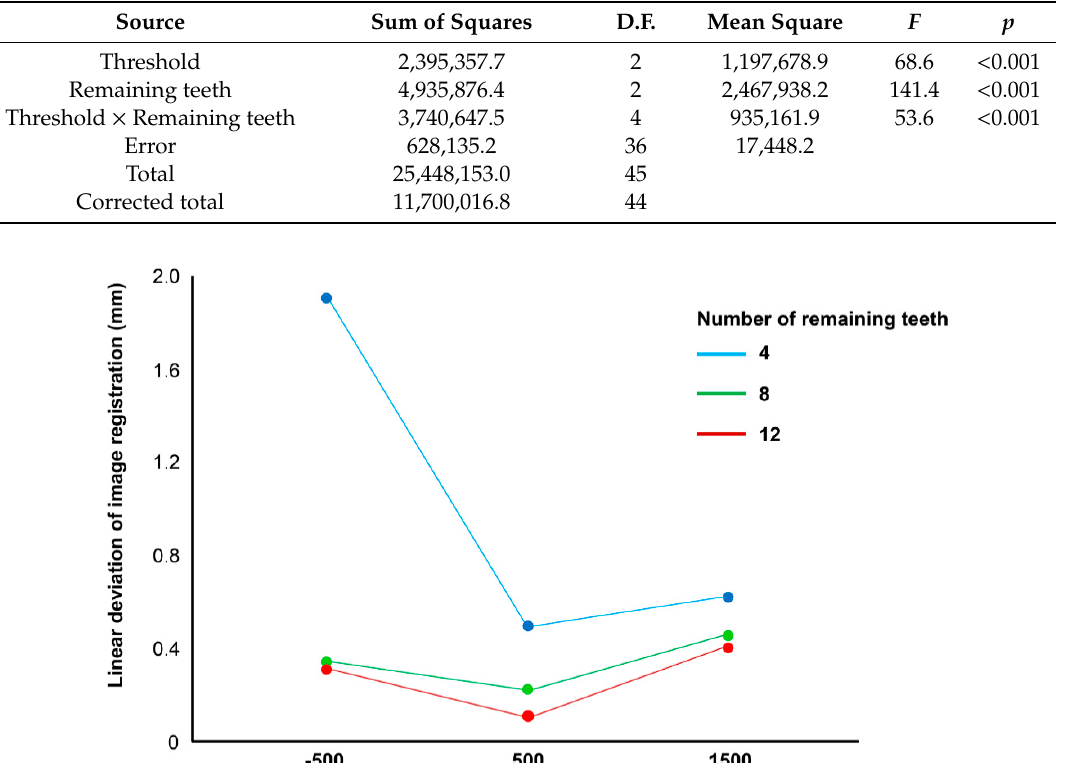
Table 4. Variations between the experimental factors in image registration error calculated by two-way analysis of variance.